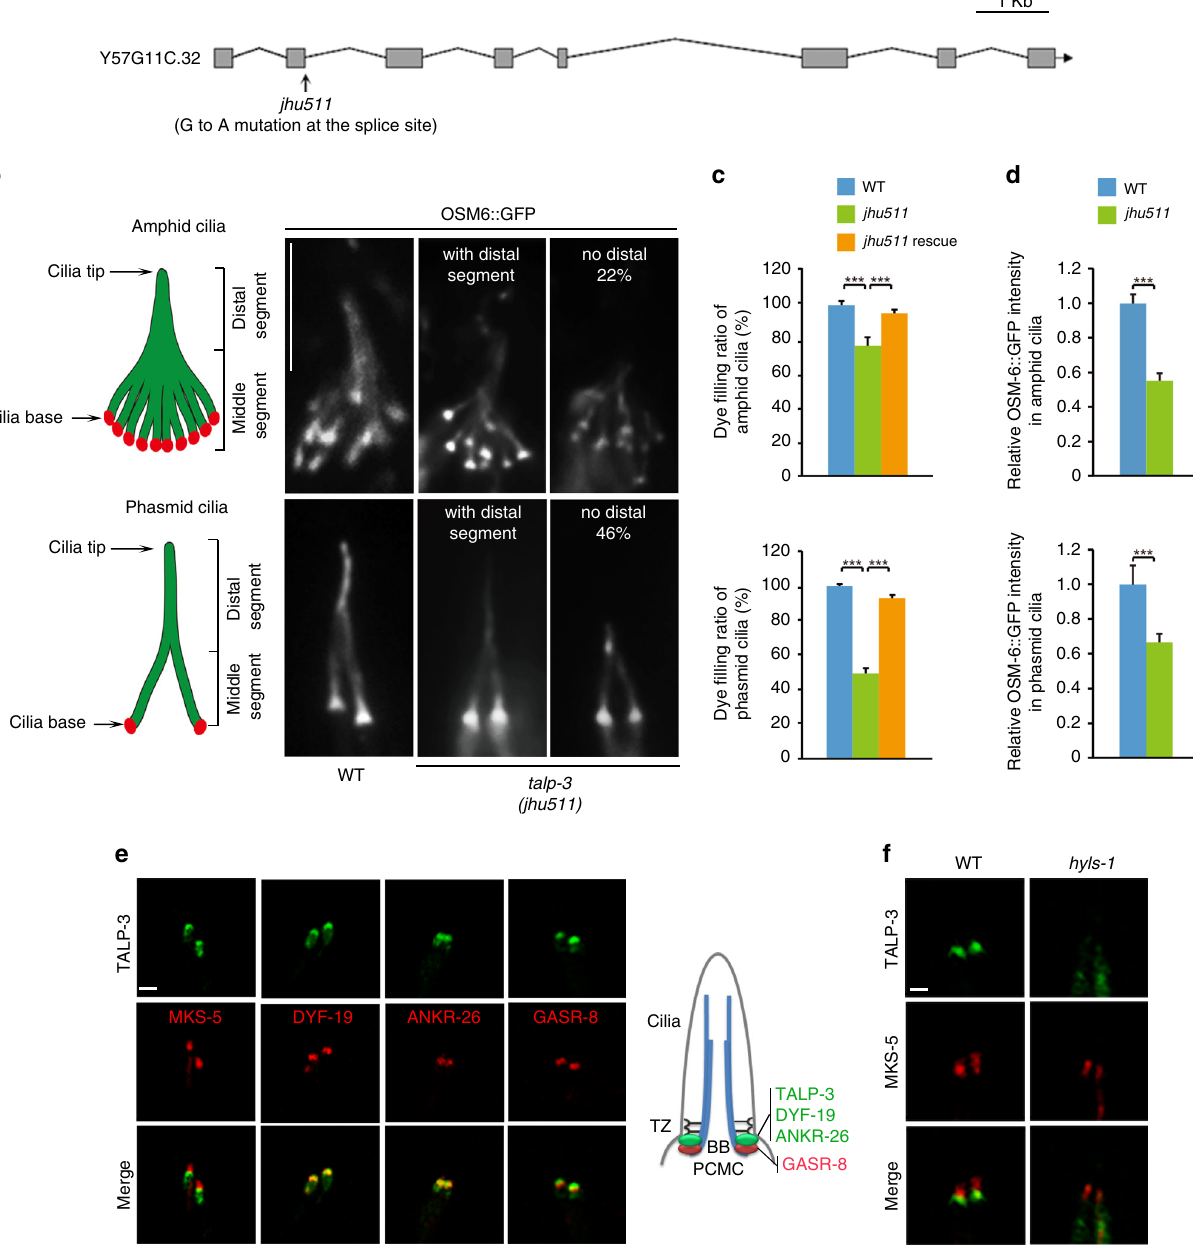
Fig. 1 TALP-3 is required for ciliogenesis in C. elegans . a Schematic representation of the C. elegans Y57G11C.32 genomic structure. jhu511 mutants obtained from a genome-wide mutagenesis screen for cilia mutants possess a G-to-A mutation at the 2nd intron donor site in the y57g11c.32 gene. This mutation changes the splice site, resulting in a 155 bp deletion in the 2nd exon, and a reading frameshift. b TALP-3 is required for cilia formation. Diagrams showing the amphid cilia and phasmid cilia in C. elegans (left panel). Representative images of cilia in WT and talp-3 (jhu511) mutants labeled with OSM-6:: GFP (right panel). Approximately 22% of amphid cilia and 46% of phasmid cilia in the jhu511 mutants are truncated. c Quanti fi cation of the dye- fi lling ratios of amphid cilia and phasmid cilia in WT, jhu511 mutant and jhu511 rescue animals. Ciliogenesis defects in jhu511 are rescued by introducing a copy of the WT Y57G11C.32 gene. n = 300 worms over three independent experiments. d Relative fl uorescence intensity of OSM-6::GFP in amphid cilia and phasmid cilia in WT and jhu511 mutant worms. WT, n = 39; jhu511 , n = 39. e Co-labeling of TALP-3::GFP with the indicated TZ- and basal body-associated proteins tagged with mCherry. TALP-3 localizes immediately below the TZ protein MKS-5 and colocalizes with the TF proteins DYF-19 and ANKR-26. f HYLS-1 is required for the proper basal body localization of TALP-3. Data are represented as the mean value ± s.d. Signi fi cant differences were identi fi ed by two-tailed unpaired Student ’ s t test. *** P < 0.001. Bars, 5 μ m in b , 1 μ m in e , f . Source data are provided as a Source Data fi HYLS-1 regulates the localization of TALP-3 to TFs . We pre- TF-adjacent protein GASR-8 lost their ability to target the cilia base in hyls-1 mutants 48 . Accordingly, GFP-tagged TALP-3 lost viously showed that HYLS-1, the ortholog of hydrolethalus syn- its speci fi c enrichment in TFs in hyls-1 mutants, and was dis- drome protein 1, is required for TF integrity in C. elegans 48 . The identi fi ed worm TF components DYF-19 and ANKR-26 and the persed at the periciliary membrane compartment (PCMC), a